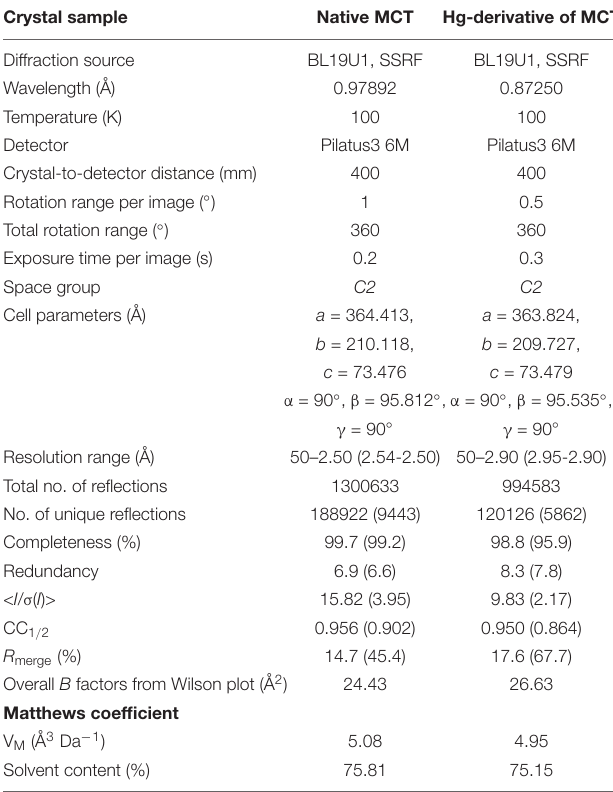
TABLE 1 | Data collection and processing statistics of R. castenholzii